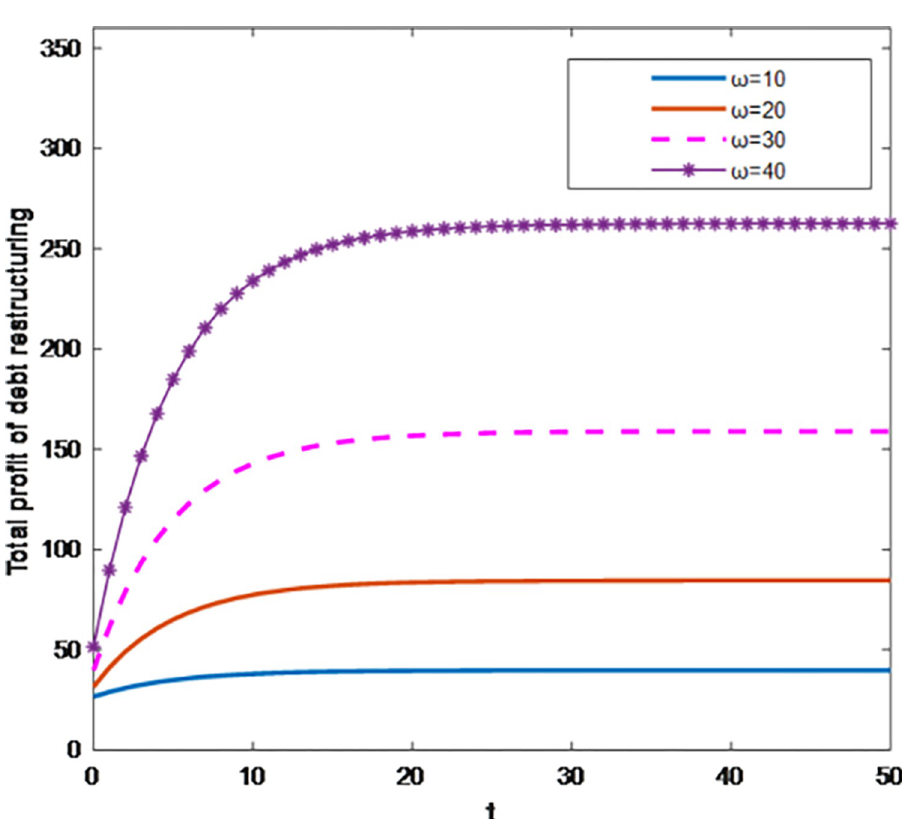
Fig 4. Effect of parameter ω on total profit of debt